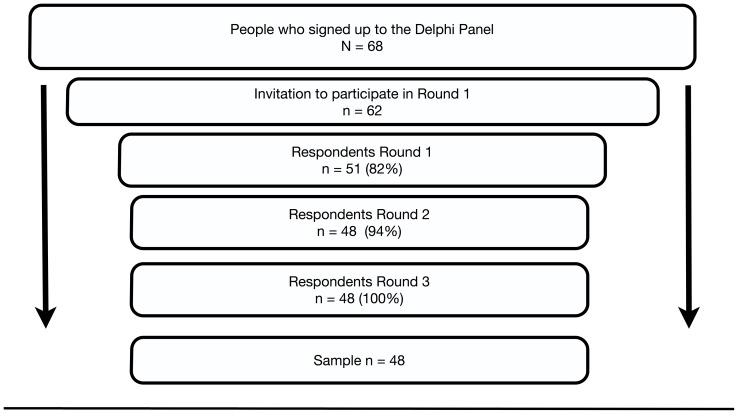
Participant Flow.Legend: N = sample completing round; % = % participants having completed the prior round, to complete the following round.